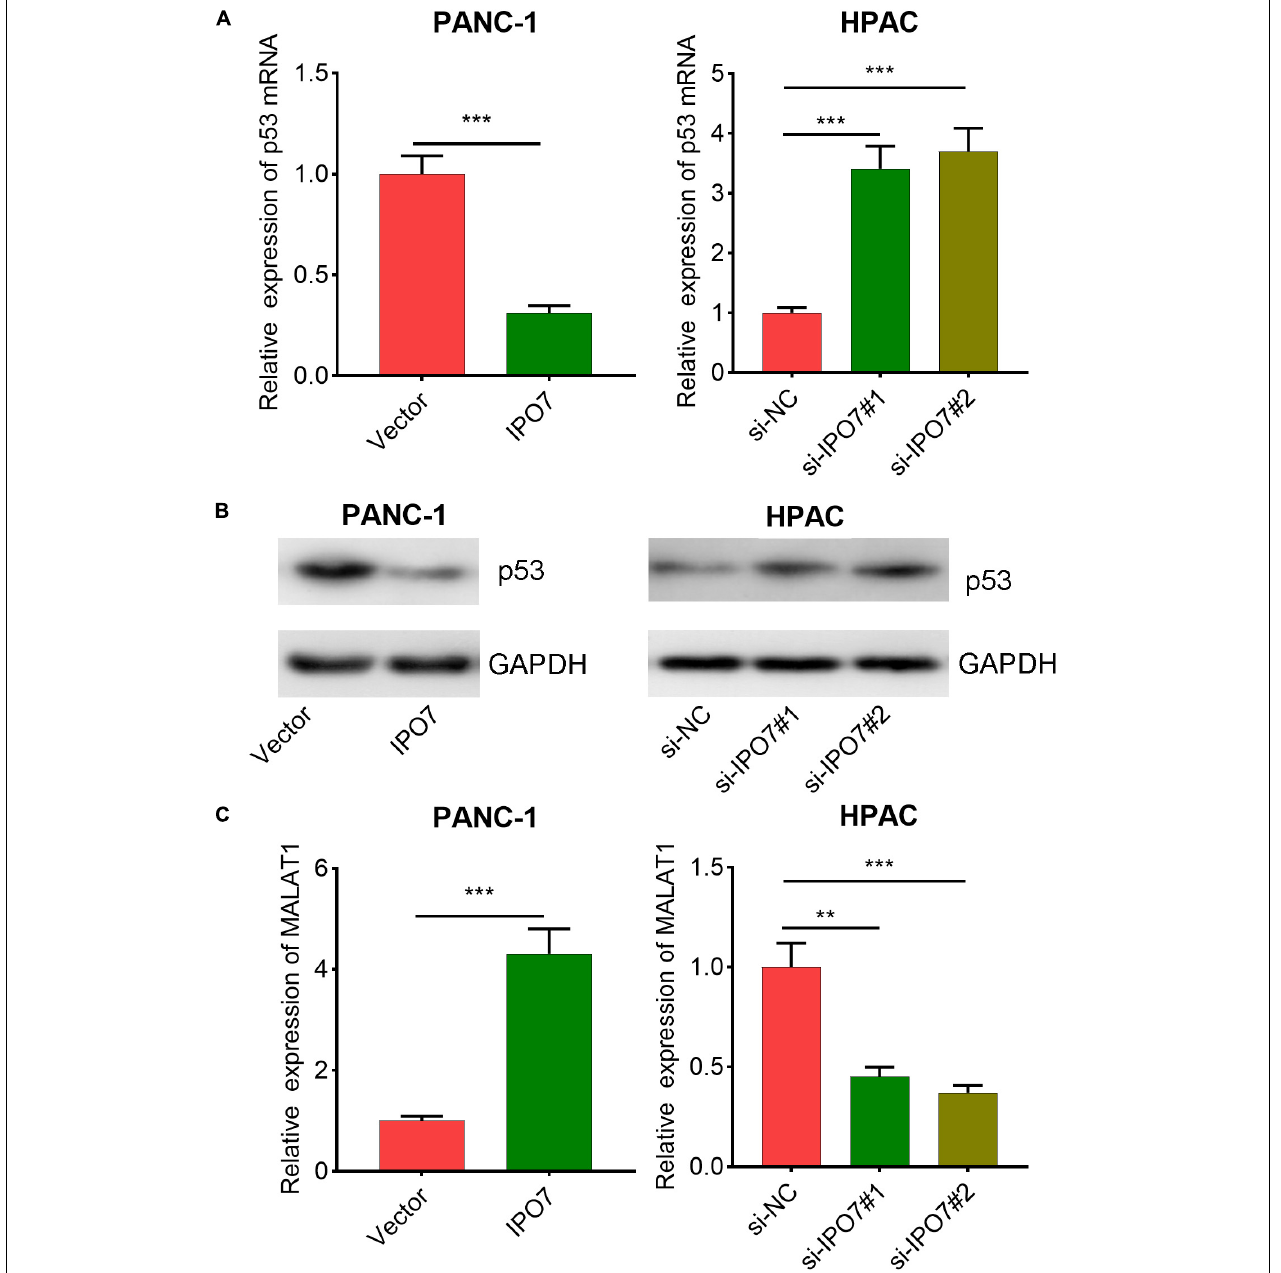
FIGURE 5 | p53 and metastasis-associated lung adenocarcinoma transcript 1 (MALAT1) are regulated by importin 7 (IPO7). (A) The expression of p53 mRNA in PANC-1 cells with IPO7 overexpression and HPAC cells with IPO7 knockdown was detected by qPCR. (B) The expression of p53 in PANC-1 cells with IPO7 overexpression and HPAC cells with IPO7 knockdown was detected by Western blot. (C) The expression of MALAT1 in PANC-1 cells with IPO7 overexpression and HPAC cells with IPO7 knockdown was detected by qPCR. ** p < 0.01, *** p < 0.001.